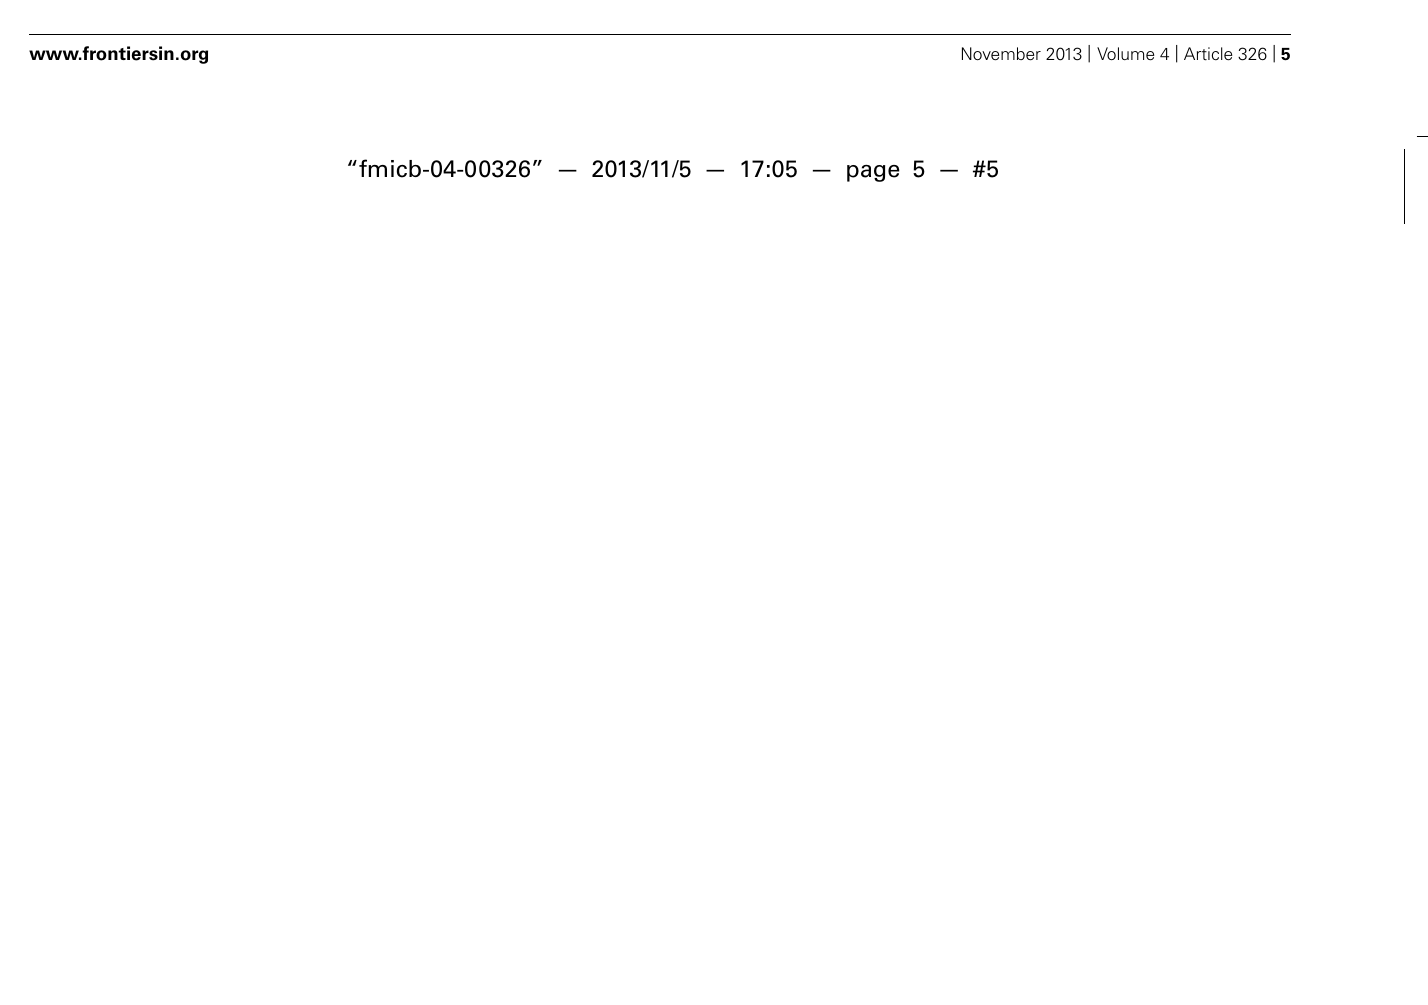
controls (PC) (from top to bottom, Nitrosospira multiformis 25196, Nitrosospira sp. NpAV, and Nitrosomonas europaea 19178) and molecular weight markers (marker), respectively. (D) Cluster analysis for intergenic profiles from four blocks and all seven treatments (see